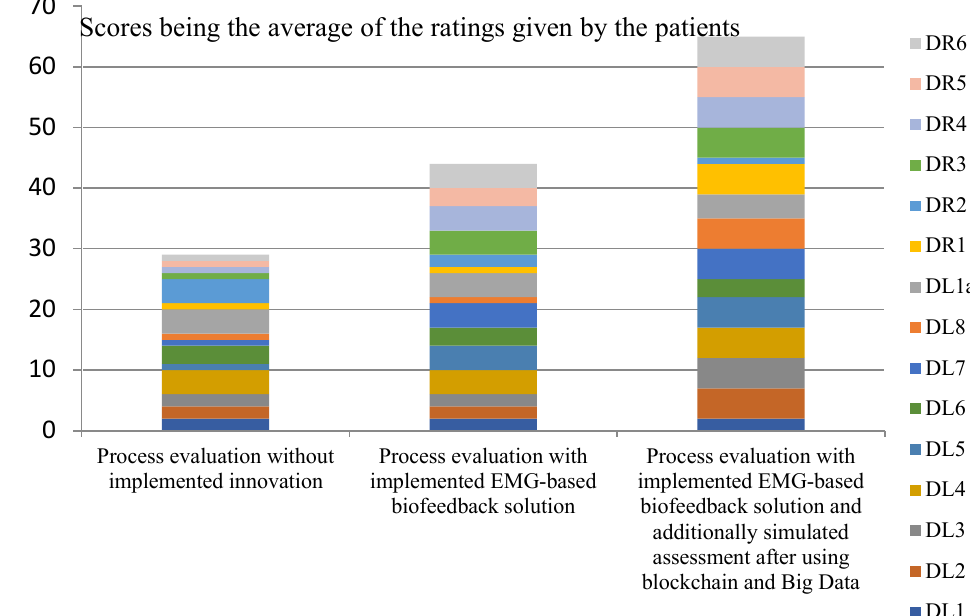
Figure 1. Assessments of the process steps by cost. Source: Authors’ own elaboration based on primary studies.